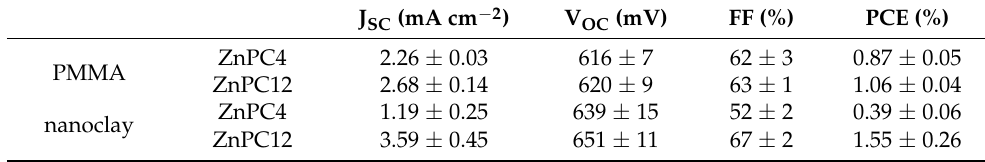
Figure 4. J–V curves under illumination and in the dark for DSSCs with PMMA electrolyte ( A ) and nanoclay ( B ). IPCE spectra of the related devices ( C ). Nyquist plots of the DSSCs under illumination with equivalent circuit used ( D ). Table 1. Photovoltaic parameters for DSSCs based on PMMA and nanoclay electrolytes.